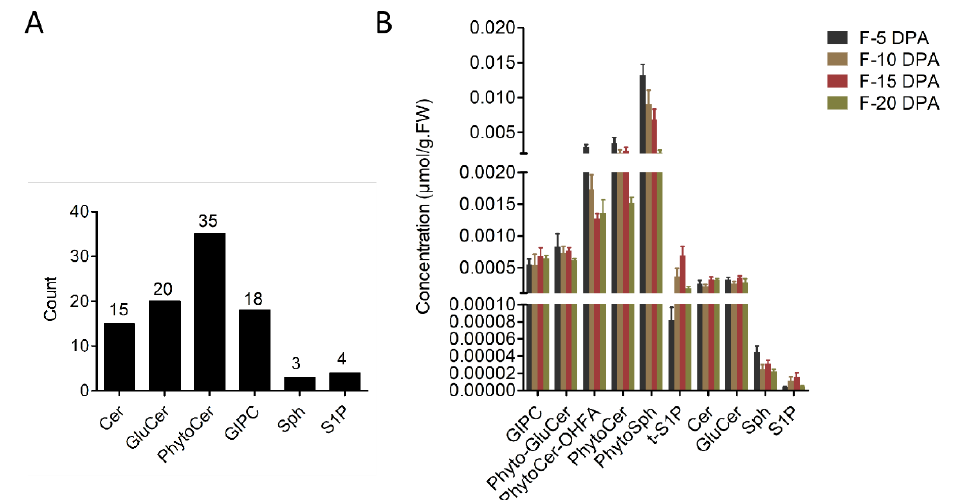
Figure 1. Sphingolipid classes in cotton fiber cells and their alteration trends during fiber growth. ( A ) The number of classes and molecular species of sphingolipids detected in fiber cells. ( B ) The content of sphingolipid classes at four developmental stages of cotton fiber cells. Cer, ceramides; PhytoCer, phytoceramides; PhytoCer-OHFA, phytoceramides with hydroxylated fatty acyls; S1P, sphingosine-1-phosphate; t-S1P, phytosphingosine-1-phosphate; Sph, sphingosines; PhytoSph, phytosphingosines; GluCer, glucosylceramides; Phyto-GluCer, phyto-glucosylceramides; GIPC, glycosyl-inositol-phospho-ceramides. F-5 DPA, F-10 DPA, F-15 DPA, and F-20 DPA represent fiber